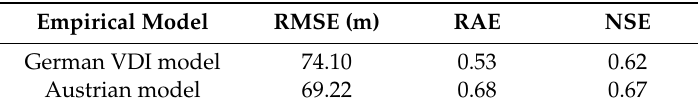
Table 3. Statistics of the separation distances determined by empirical models related to AERMOD. The evaluation was performed by the root mean square error RMSE, the relative absolute error